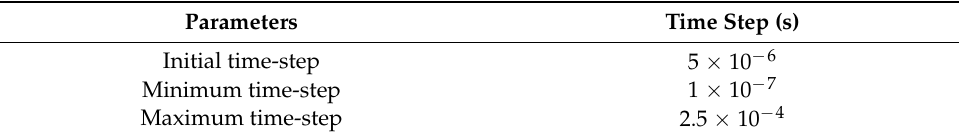
Table 3. Time step of